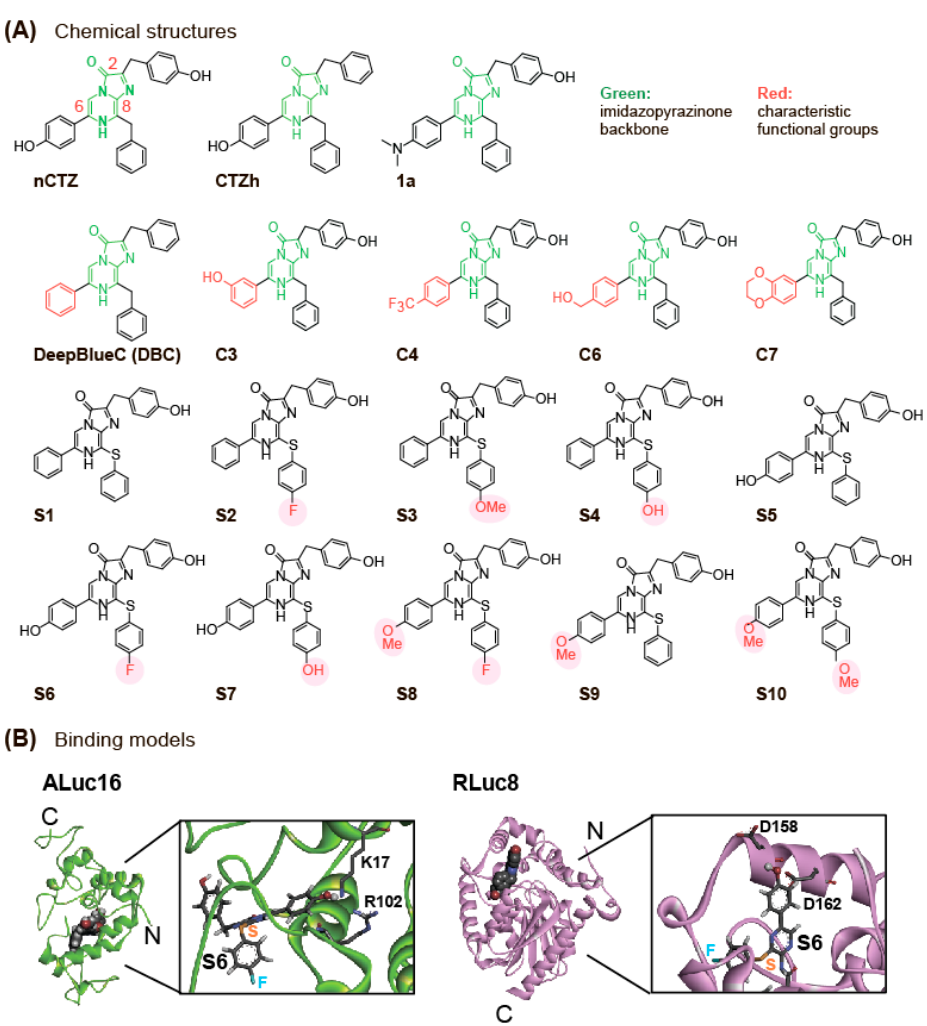
Figure 1. ( A ) Chemical structures of S-series CTZ analogues, together with conventional ones, were used in this study. The imidazopyrazinone backbone is highlighted in green. The characteristic func- tional groups are shadowed in red. Abbreviations are as follows: nCTZ, native coelenterazine; CTZh, coelenterazine h; DBC, DeepBlueC. The structures of 1a , C3 , C4 , C6 , and C7 were obtained from our precedent studies [15,26]. ( B ) Putative three-dimensional (3-D) structures of ALuc16 and